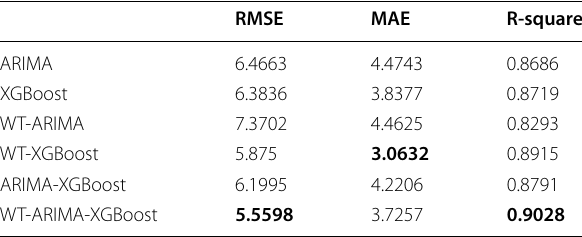
Table 2 Evaluation indicator values for one-step prediction of layer actions response